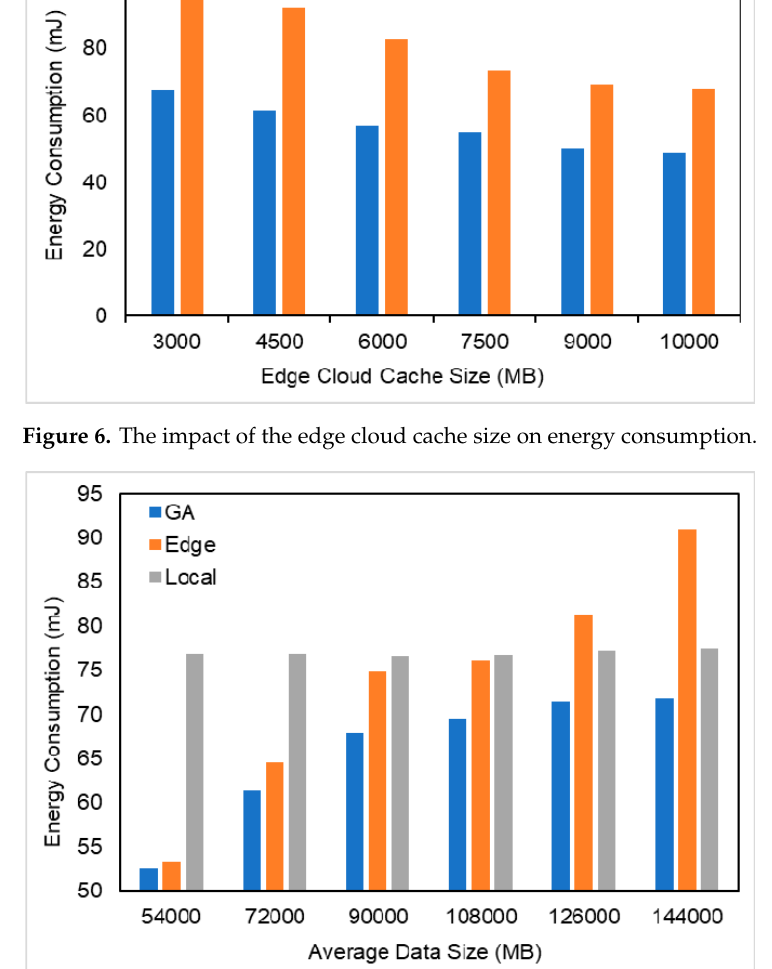
Figure 7. The impact of average data size on energy consumption.